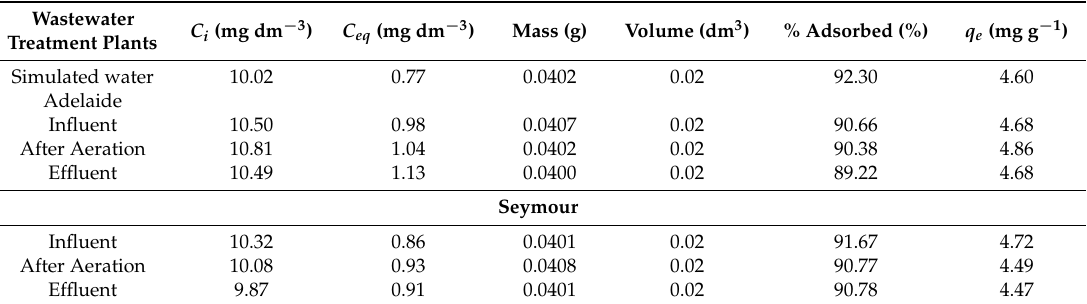
Table 10. Analytical data for real wastewater samples at pH 6.0, 200 rpm, 20 ◦ C, 0.040 g of adsorbent, 20 cm 3 of adsorbate for 4 h for